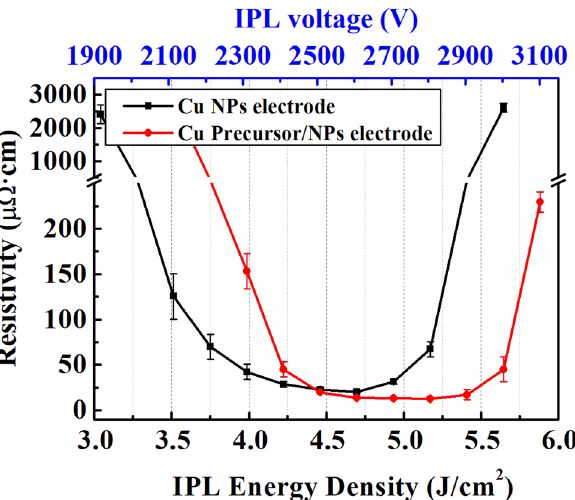
Figure 4. A plot of resistivity changes in Cu and CPN electrodes with respect to applied IPL irradiation